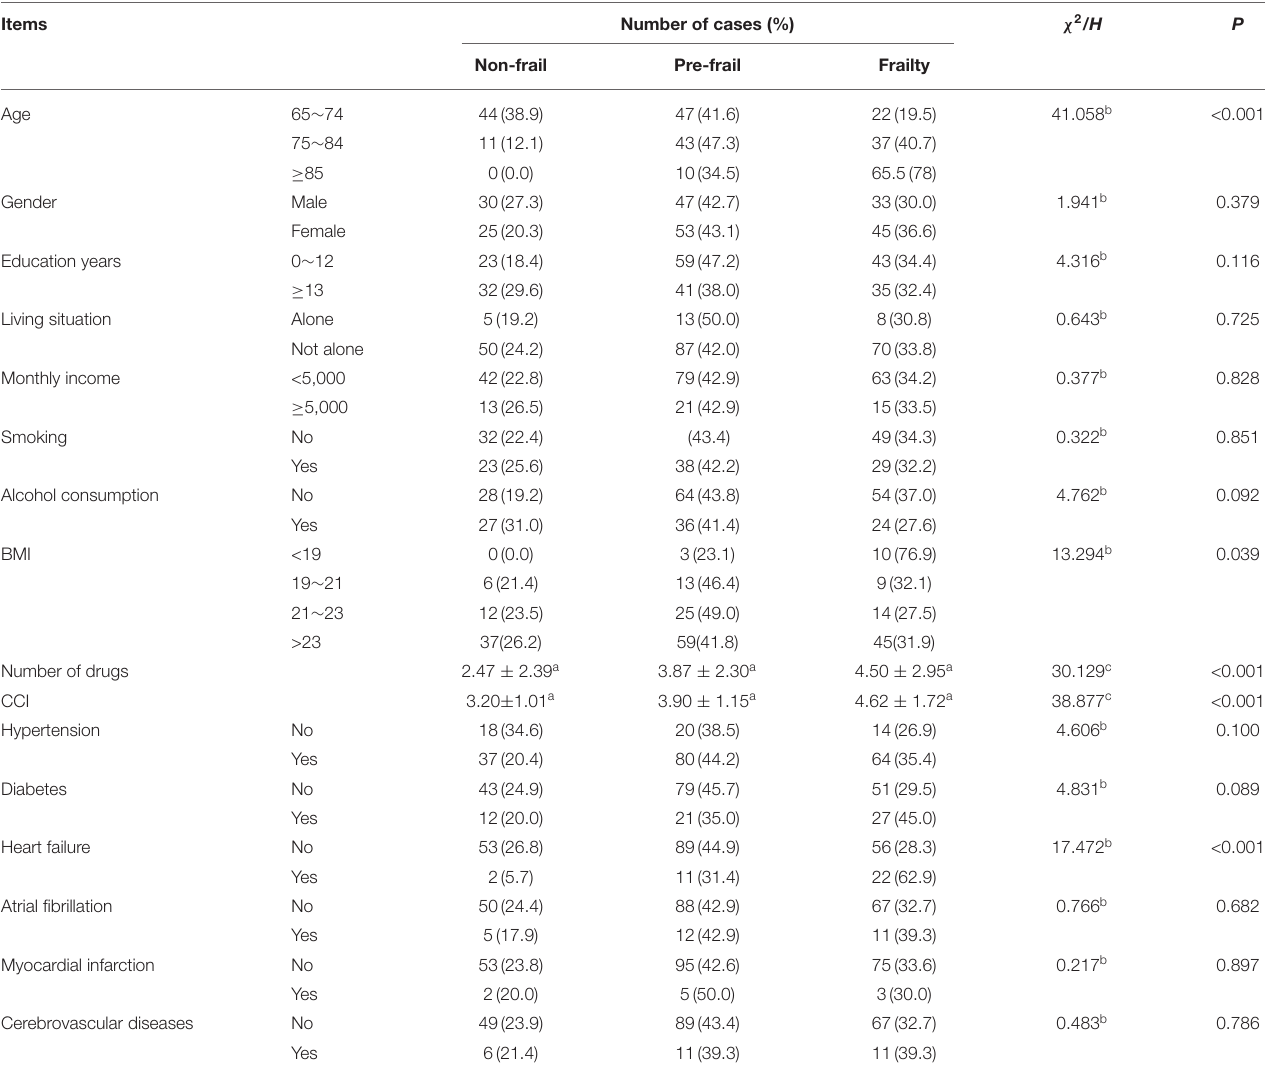
TABLE 2 | Univariate analysis of sociodemographic characteristics in elderly patients with